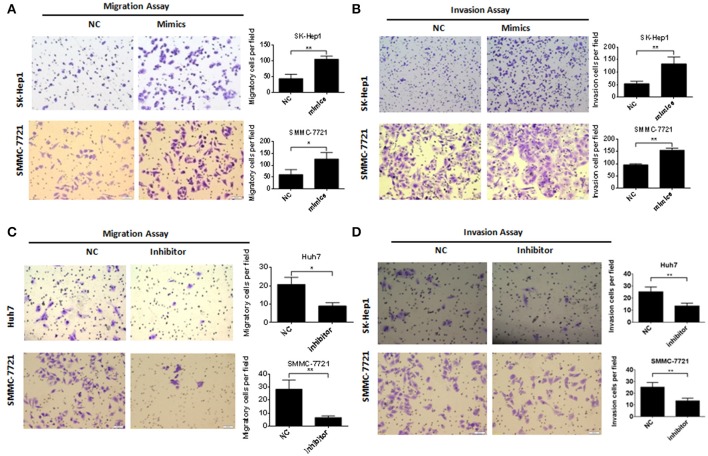
miR-483-5p promoted HCC cells migration and invasion. (A) miR-483-5p mimics promoted HCC cells migration. (B) miR-483-5p mimics promoted HCC cells invasion. (C) miR-483-5p inhibitor suppressed HCC cells migration. (D) miR-483-5p inhibitor suppressed HCC cells invasion. *p < 0.05; **p < 0.01 ×40.